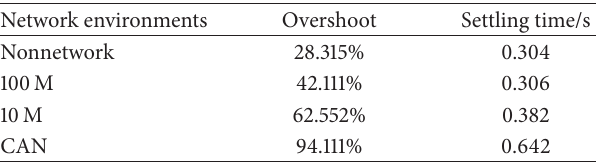
Table 1: The performance indexes of the control systems. Network